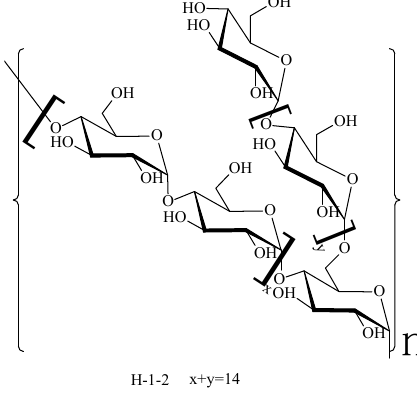
Figure 4. The possible structure unit of polysaccharide H-1-2.